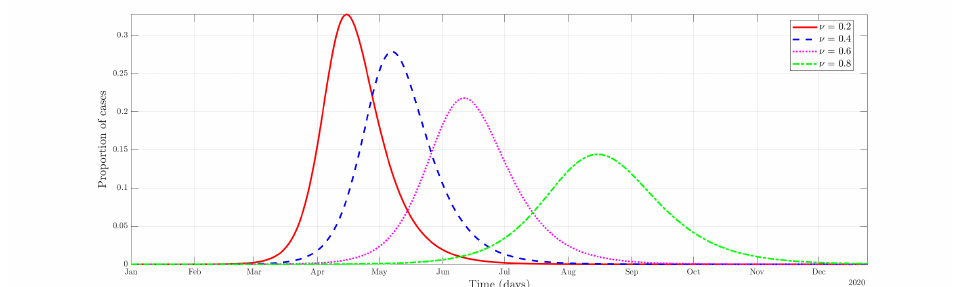
Figure 1. Disease dynamics of the combined infectious category ( A + I ) with different protective measures